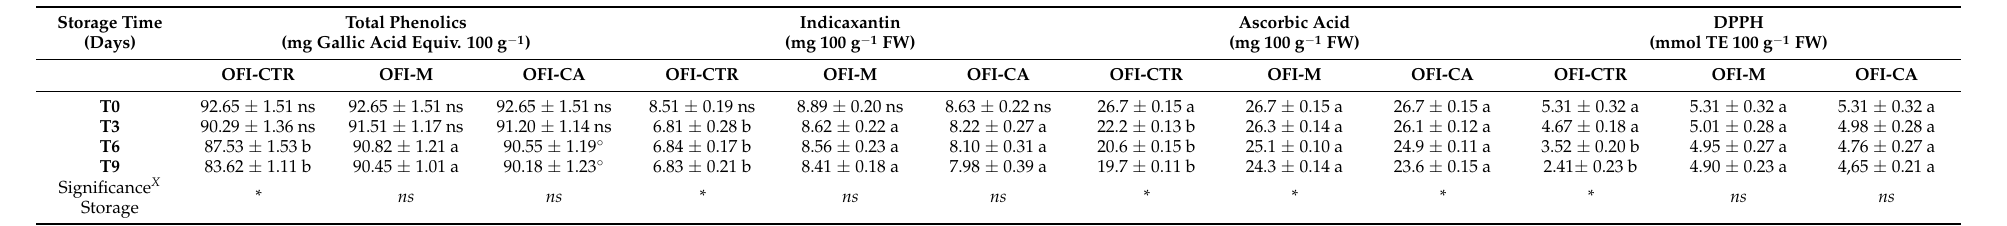
Table 2. Changes in Total phenolics, Indicaxantin, Ascorbic Acid and DPPH in minimally processed O. ficus-indica fruits non-treated (OFI-CTR) and treated with mucilage (OFI-M) and calcium ascorbate coating (OFI-CA) during cold storage (9 days at 5 ◦ C). Different lowercase letters indicate significant differences between the treatments in each sampling date. Data are the mean ± SE ( n =